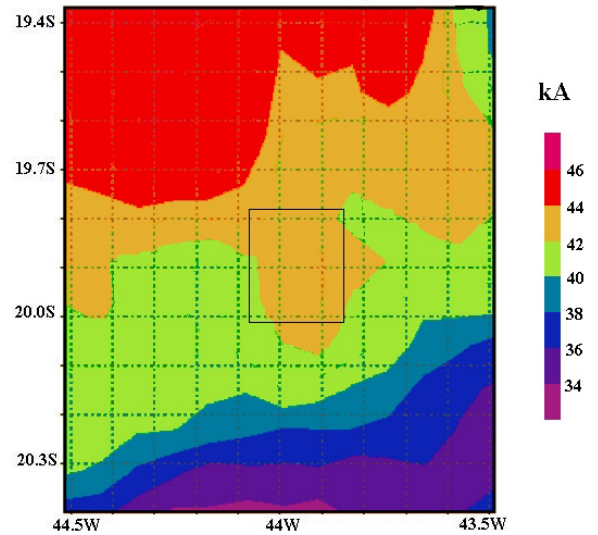
Fig. 7. Mean altitude map in meters centered on Belo Horizonte (indicated by a black rectangle), at a spatial resolution of